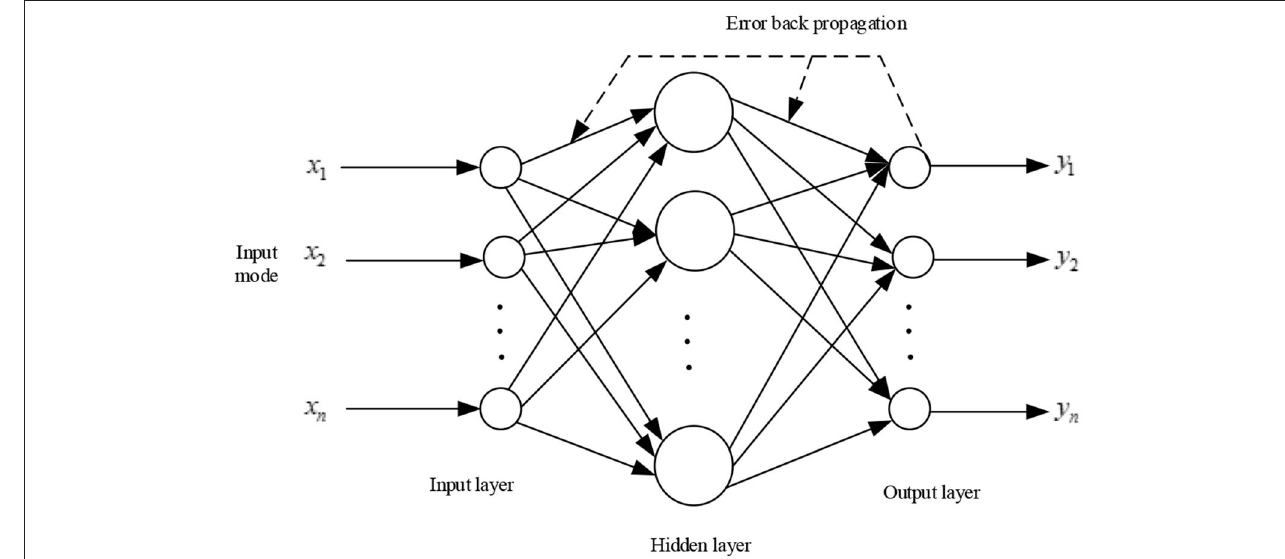
FIGURE 6 | Back propagation (BP) network model.